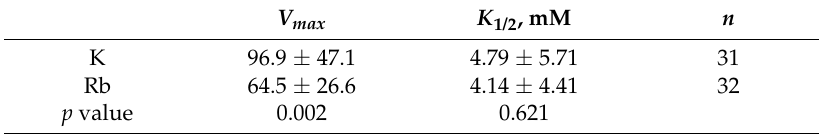
Figure 4. Substrate affinities of the Na,K-ATPase for K + and Rb + . Na,K-ATPase activity was measured using an ATPase turnover assay and a sarcolemmal-enriched membrane preparation obtained from WT mouse EDL. K + or Rb + concentrations were varied by equimolar replacement with choline chloride at constant osmolarity. [Na + ] i was fixed at 80 mM to saturate substrate stimulation by Na + , and [K + ] or [Rb + ] was varied from 1–15 mM. Each symbol reports the mean and SEM of triplicate measurements on 3–4 samples at the indicated concentration (total of 32 and 31 samples for Rb + and K + , respectively). Solid lines show a best fit of the data to the Michaelis–Menten equation (Table 2). Table 2. Maximum turnover rate and affinity constants of Na,K-ATPase for K + and Rb + .